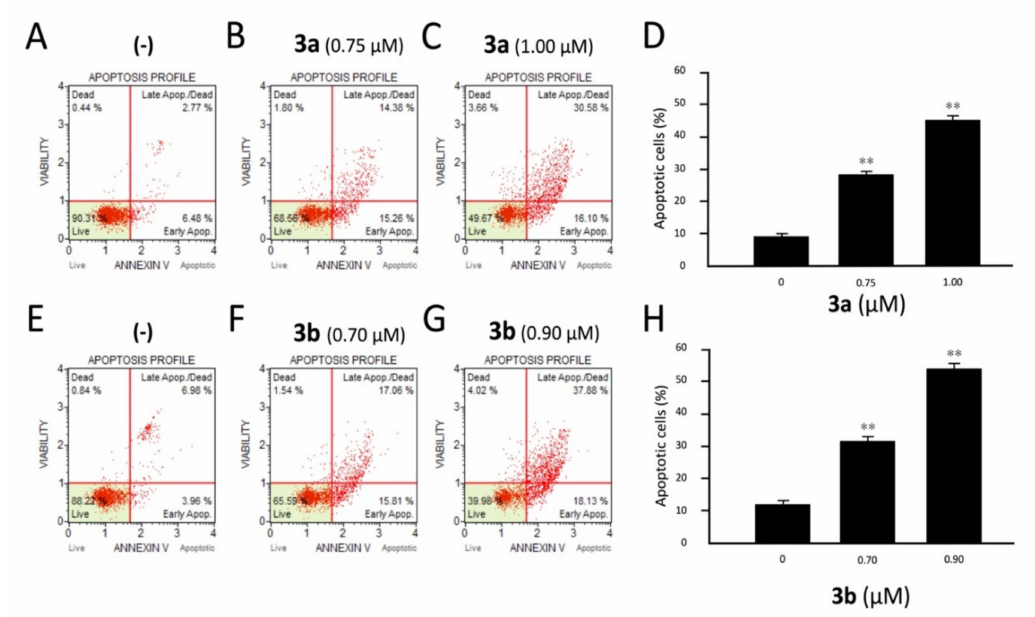
Figure 3. E ff ects of the tetrahydrothieno[2,3- c ]pyridines 3a and 3b on apoptosis. K562 cells were treated with compounds 3a ( A – D ) and 3b ( E – H ), and apoptosis was analyzed by cytofluometry. Analyses were performed after 3 days of cell culture at the indicated concentrations of 3a and 3b compounds. In panels A – C and E – G , representative analyses of apoptosis are reported for compound 3a ( A – C ) and compound 3b ( E – G ). In panels D and H, a summary of three independent experiments is presented. The data represent the average ± S.D. **: highly significant ( p <